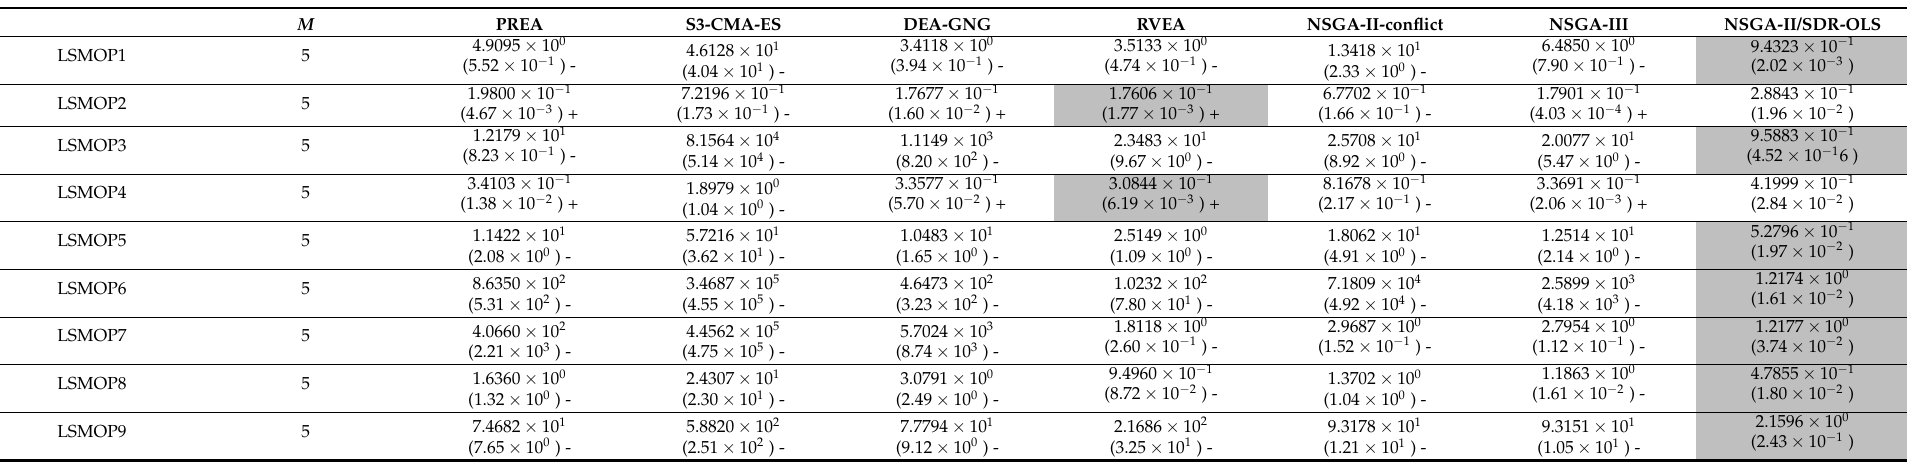
Table 8. IGD values for 9 five-objective benchmark problems.